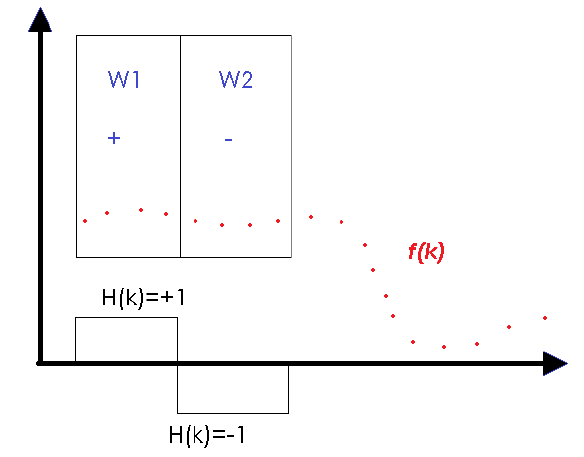
Figure 4. The effect of the block average over the windows W1 and W2 and the DWT on the function f